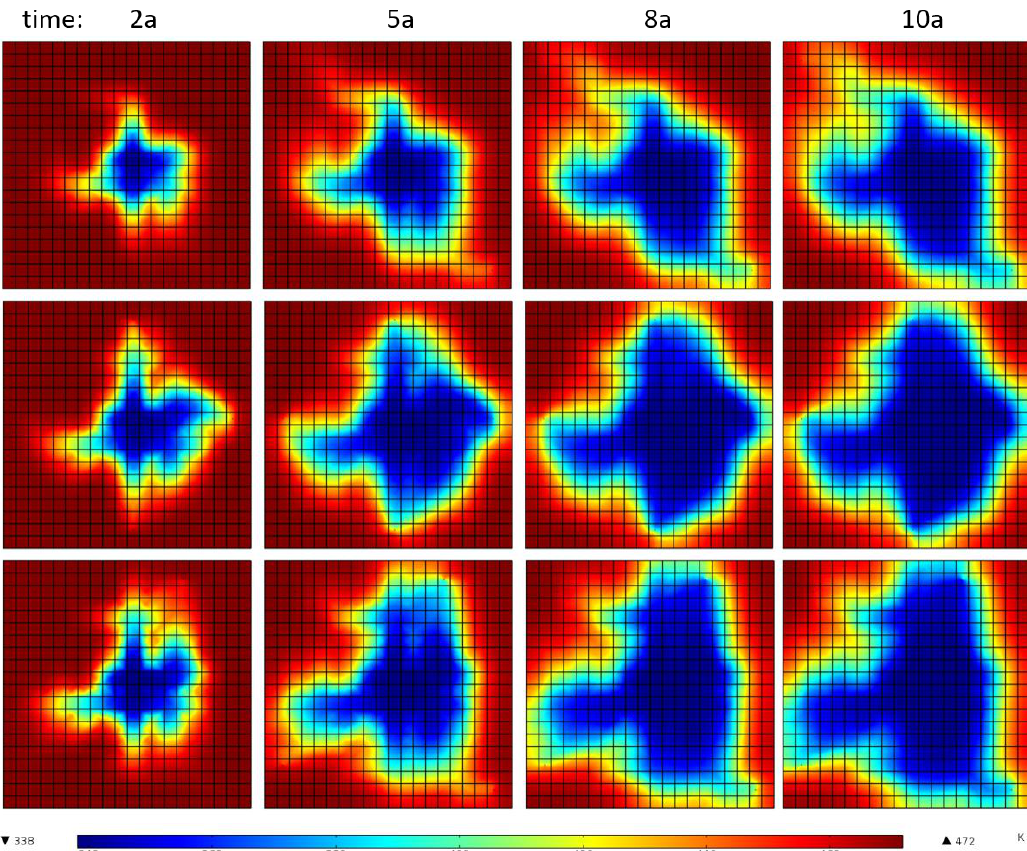
Figure 10. The temperature variations of three cases. The top is Case 1, the middle is Case 2 and the bottom is Case 3 (optimization result). bottom is Case 3 (optimization